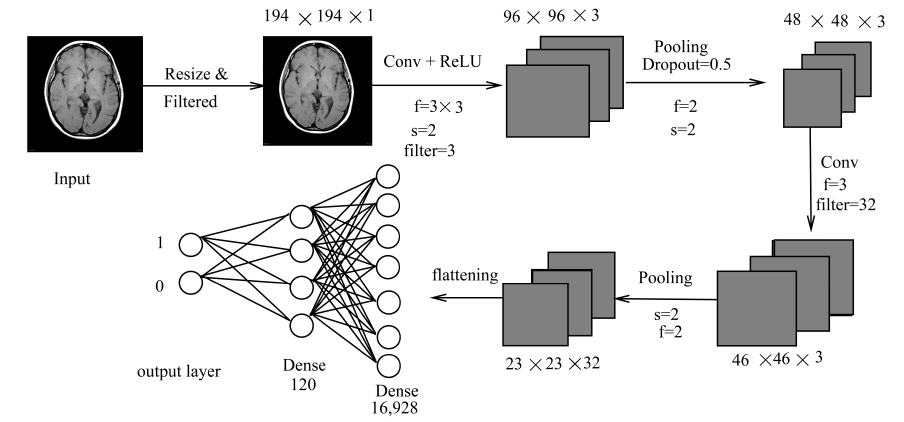
Figure 2. LeNet inspired model